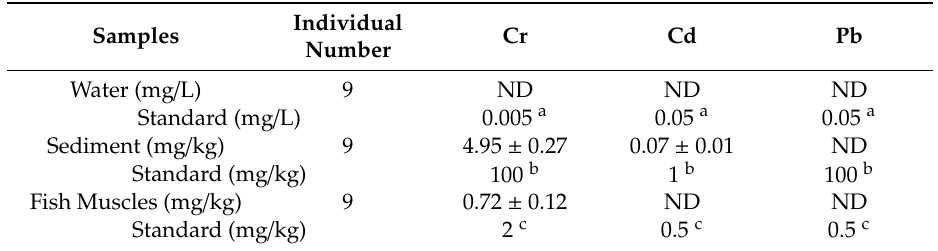
Table 4. Heavy metal concentrations in the water, sediment and fish muscles from the reference reservoir (mean ± standard deviation; n = 9).